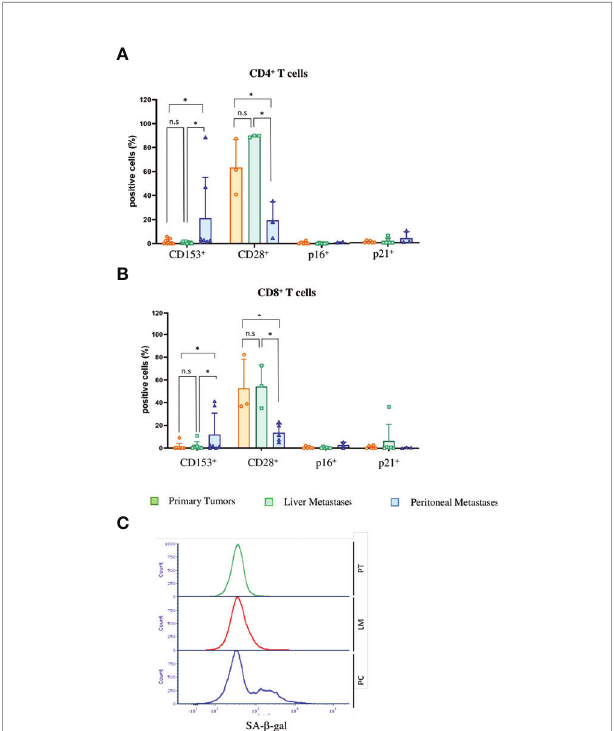
FIGURE 6 | Tumor-in fi ltrating lymphocytes in PC show signs of immunosenescence in mice and men (A) Flow cytometric analysis of immunosenescence associated markers on tumor-in fi ltrating CD4 + T cells of primary tumors (PT), liver metastases (LM) and PC of the orthotopic organoid transplantation CRC mouse model. Dotplots show the percentage of CD4 + T cells expressing CD153 (n = 10 for PT, n = 7 for LM, n = 8 for PC), CD28 (n = 3 for PT, n = 3 for LM, n = 3 for PC), p16 and p21 (n = 10 for PT, n = 7 for LM, n = 8 for PC). (B) Flow cytometric analysis of immunosenescence associated markers on tumor-in fi ltrating CD8 + T cells of primary tumors (PT), liver metastases (LM) and PC of the orthotopic organoid transplantation CRC mouse model. Dotplots show the percentage of CD8 + T cells expressing CD153 (n = 10 for PT, n = 7 for LM, n = 8 for PC), CD28 (n= 3 for PT, n=3 for LM, n=3 for PC), p16 and p21 (n= 10 for PT, n = 7 for LM, n = 8 for PC). (C) Flow cytometric analysis of SA- b -gal in tumor-in fi ltrating lymphocytes from human patients with primary CRC (PT), liver metastasis and PC. The histogram shows the results of 5 patients each. Error bars represent the mean ± SD. One-way ANOVA (A, B) *p < 0.05, n.s. = not signi fi